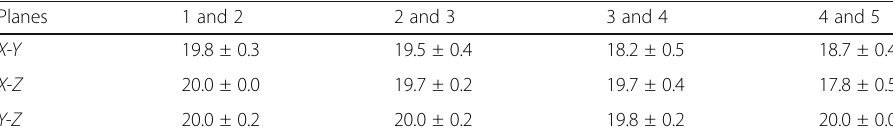
Table 2 Calculated distance between point source planes (in millimeters) Planes 1 and